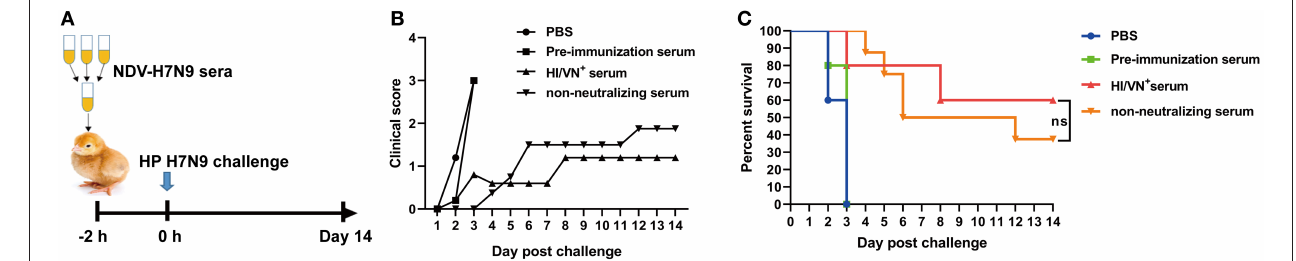
FIGURE 5 | Passive transfer challenge study of non-neutralizing sera. (A) Schematic illustration for the serum transfer experiment. (B) Clinical scoring and (C) survival of chickens after H7N9 virus infection. “ns” in (C) indicates non-significant